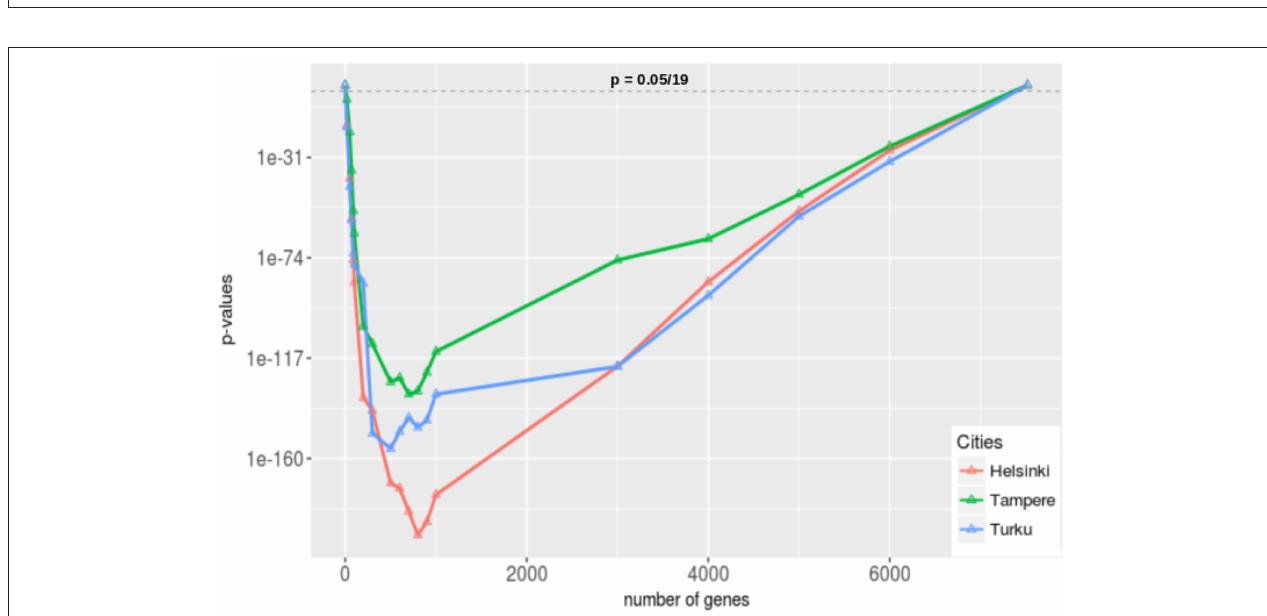
FIGURE 10 | Gene set enrichment analysis for the three cities in Finland that publish most articles in prostate cancer research (see Table 1 ). We apply a Bonferroni correction because we are testing 19 hypothesis (one hypothesis for one threshold, γ ) simultaneously.